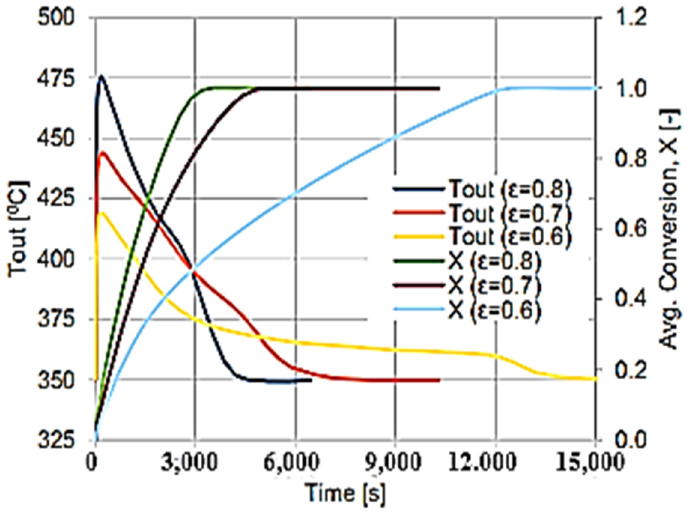
Figure 10. Outlet temperature of the HTF and the conversion as a function of time during hydration for bed porosity of 0.6, 0.7, and 0.8 in counter-current flow geometry [127].